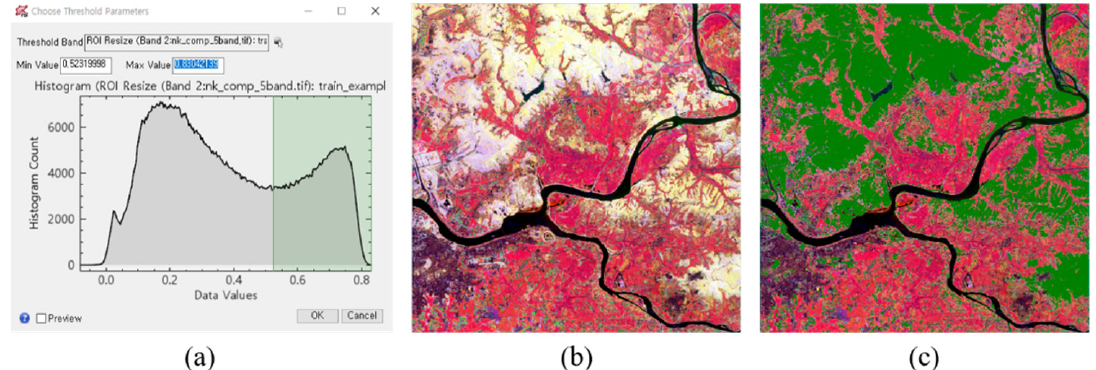
Figure 5. Deep learning labeling tool and training data: ( a ) band threshold setting tool; ( b ) training raster data; and ( c ) forest labeled raster data.